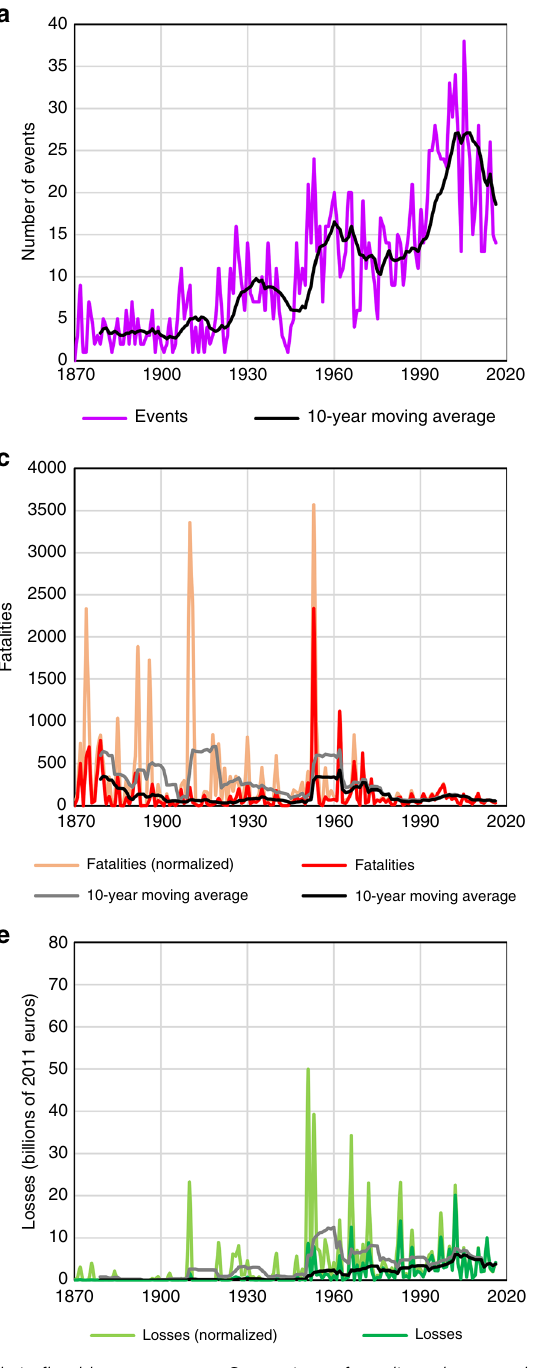
Fig. 3 Trends in fl ood losses per year. Comparison of unadjusted, reported values (dark colors) and normalized values, i.e., adjusted to 2011 levels of exposure (lighter colors), for a number of events; b area inundated; c fatalities; d persons affected; e fi nancial value of losses with normalization by